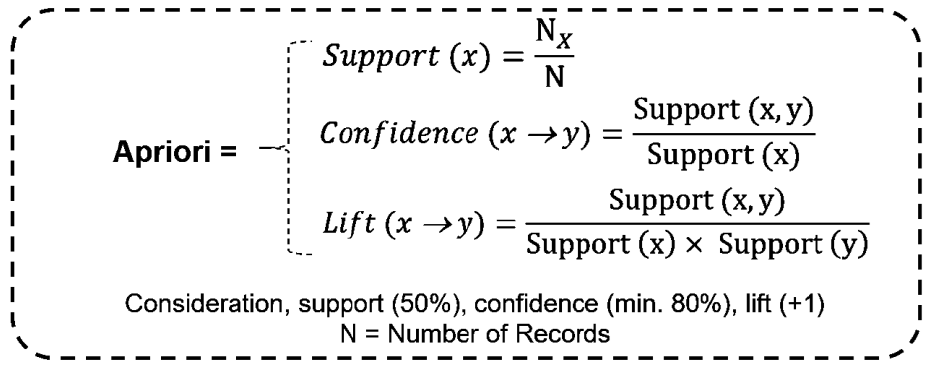
Figure 9. Mathematical modeling of the “ Apriori ” algorithm [50].